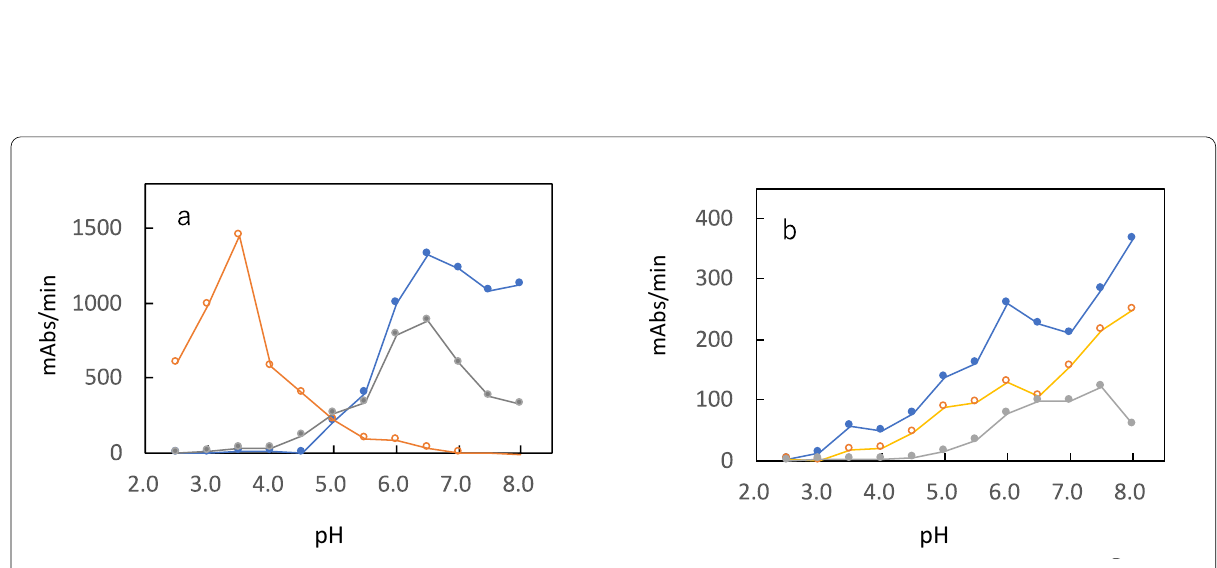
Fig. 4 Laccase activity of water-soluble extracts from acetone powder prepared from the lacquer. a Yellow line shows laccase activity measured with ABTS; blue line, SA; gray line, 2,6-DMP. b yellow line, 4MC; blue line, 3MC; gray line,